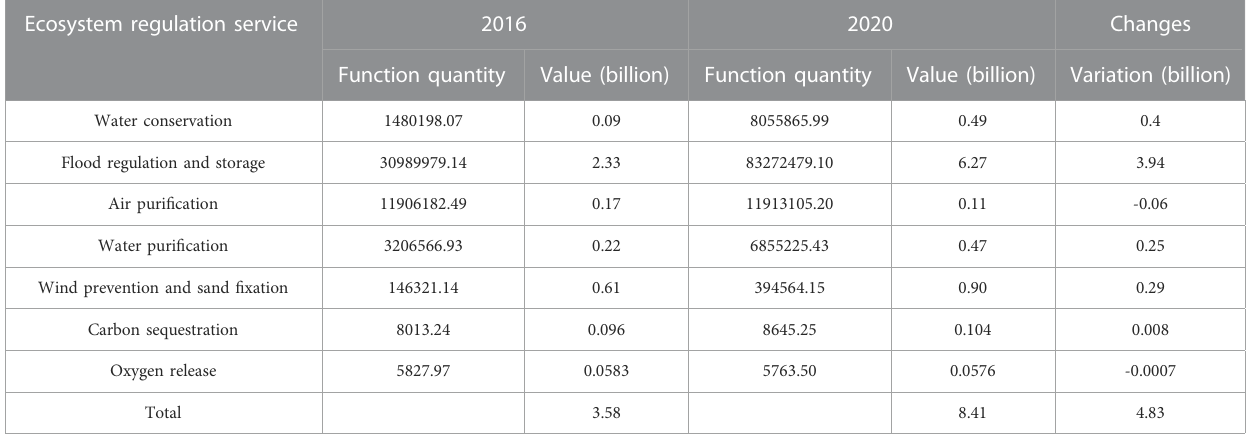
TABLE 5 Changes of function quantity and value of regulation services in 2016&2020. Ecosystem regulation